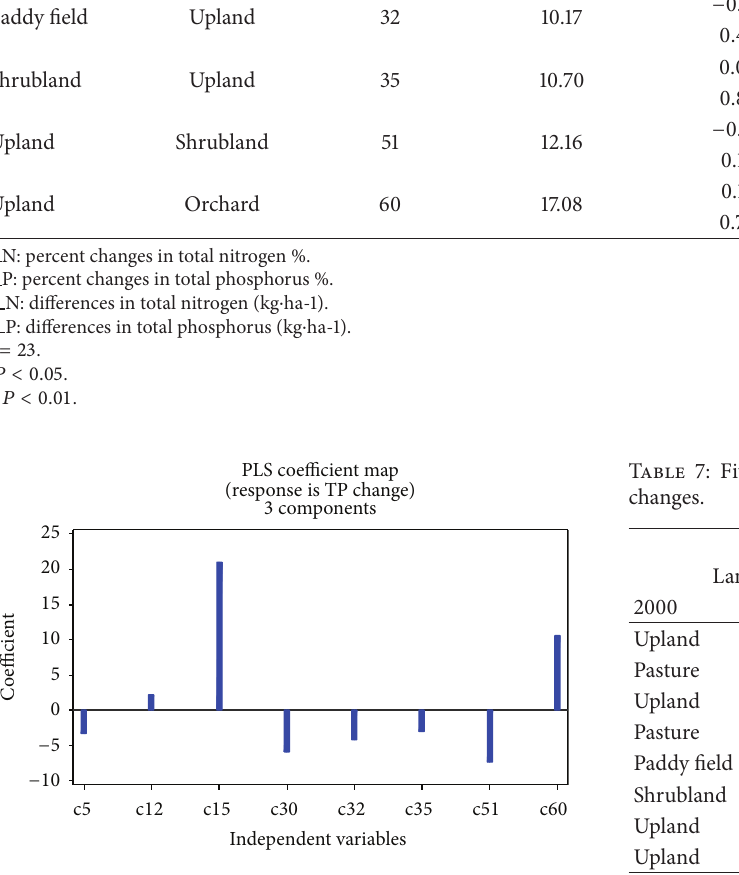
Figure 9: Coefficient map of TP PLRS results.